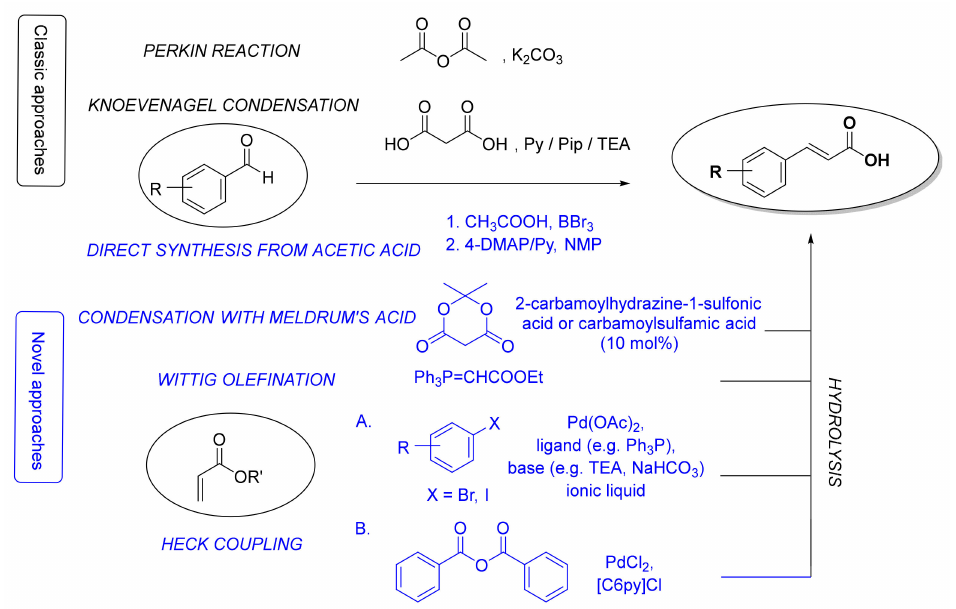
Figure 2. The most common classic (in black) and novel (in blue) synthetic methods for the synthesis of cinnamic acid moieties. Py, pyridine; Pip, piperidine; TEA, triethylamine; 4-DMAP, 4-dimethylaminopyridine; NMP, N -methyl-2-pyrrolidone; [C6Py]Cl, N -hexylpyridinium